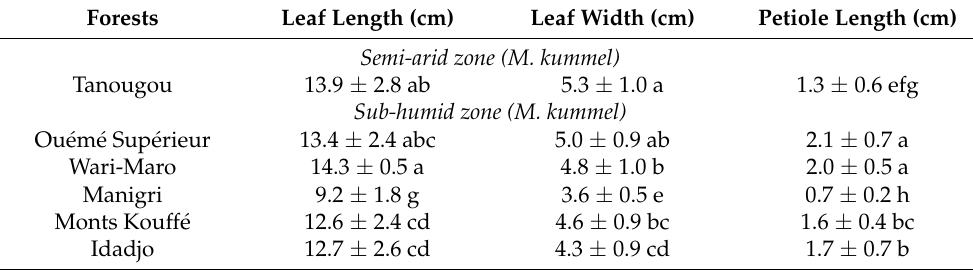
Table 3. Leaf morphological characteristics (means ± SD) in the investigated forests. Forests Leaf Length (cm) Leaf Width (cm) Petiole Length (cm) Semi-arid zone (M. kummel) Tanougou 13.9 ± 2.8